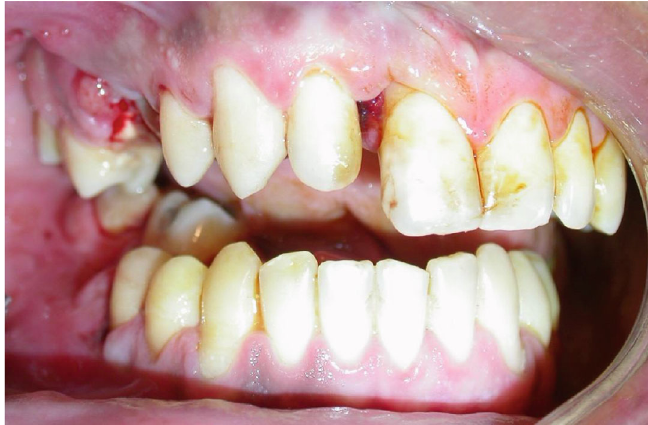
Figure 1: Initial appearance of the intraoperative showing apical fragment intrusion.